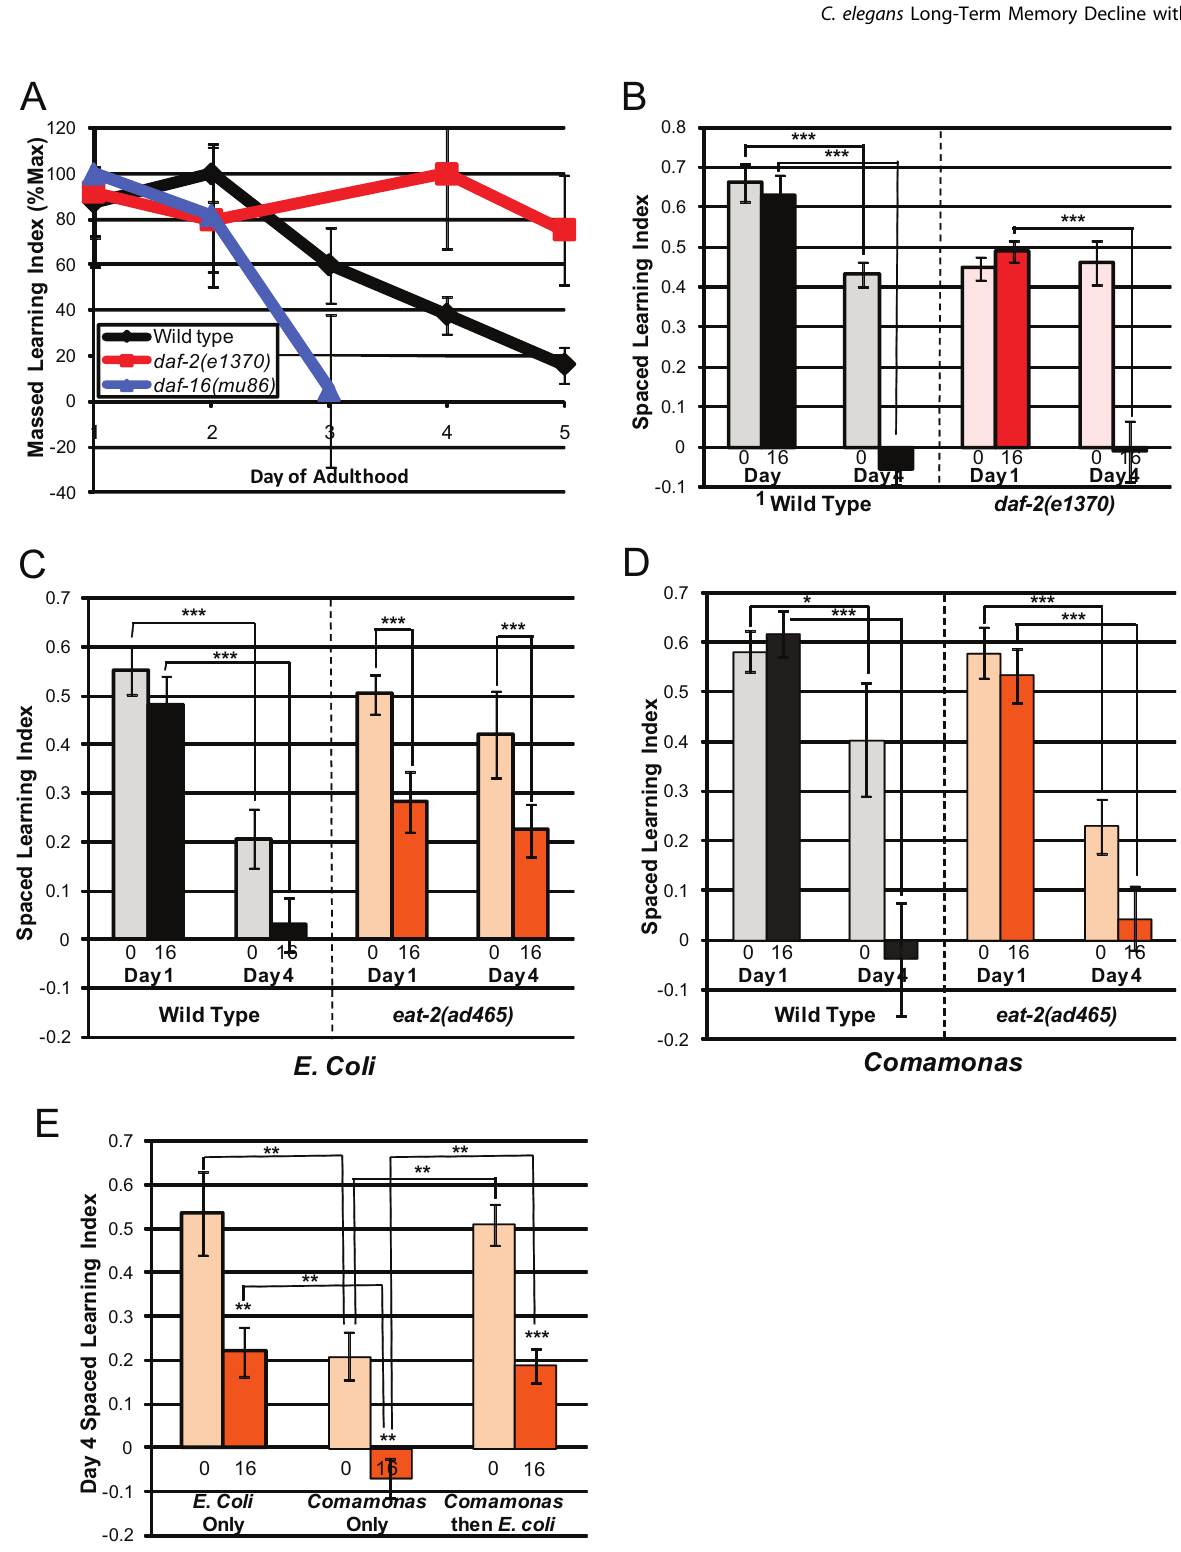
Figure 8. Reduced insulin signaling and Dietary Restriction affect maintenance of learning and memory with age differently. (A) daf- 2(e1370) worms retain the ability to learn with massed training longer with age. (B) daf-2(e1370) animals learn better after spaced training than wild type on Day 4 of adulthood but do not display improved long-term memory with age. (C) eat-2(ad465) maintain spaced learning and memory with age, which is suppressed by feeding with Comamonas (D). (E) Post-developmental induction of Dietary Restriction improves maintenance of spaced learning and memory on Day 4 of adulthood. eat-2(ad465) worms were cultivated on Comamonas until Day 1 of adulthood, then switched to growth on E. coli . (B–D): Numbers under bars represent hours after 7 6 spaced training; (A–D): n =6 trials; (E) n =4 trials; 6 SEM; * p , 0.05, *** p ,